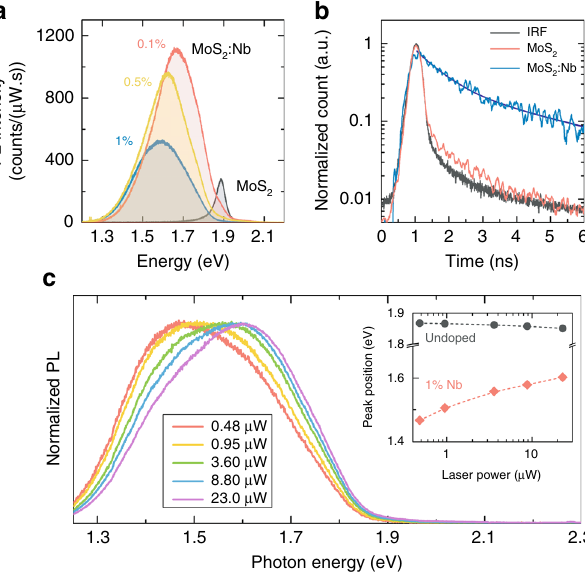
Fig. 3 Band engineering of MoS 2 by Nb doping. Schematic band structures of a multilayer, such as bulk and bilayer, and b monolayer MoS 2 before (left panel) and after (right panel) degenerate Nb doping. For the case of multilayer MoS 2 :Nb, the pristine valence bands of Nb-free MoS 2 are included as dotted black lines for a direct comparison, and the regions in the Brillouin zone ( Γ V ) where a signi fi cant band restructuring takes place are also highlighted as a blue circle. Direct (impurity-bound) and indirect transitions are indicated by red (dotted) and blue arrow lines, MoS 2 , with a much elongated PL lifetime as shown in Fig. 4b. That is, while the decay dynamics of the exciton states at ~1.88 eV in undoped MoS 2 is rather fast (lifetime, τ , on the order of 100 ps 38 ) approaching the instrumental response function (IRF), the PL at ~1.68 eV in the monolayer MoS 2 :Nb shows signi fi cantly slower bi-exponential decay dynamics ( τ 1 = 0.7 ± 0.05 ns and = 4.3 ± 0.3 ns). This is in great contrast with the earlier PL τ 2